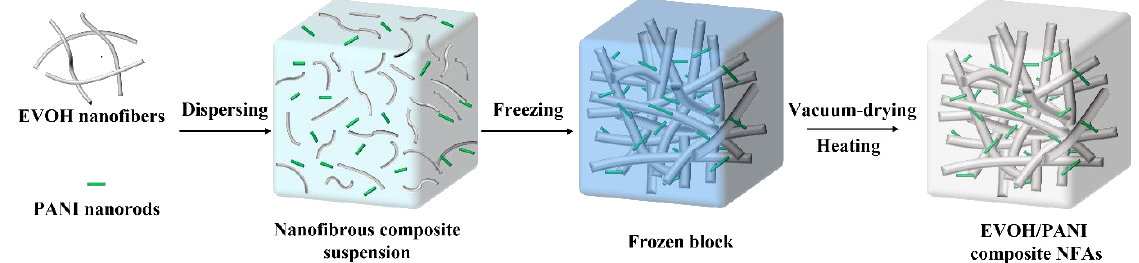
Figure 1. The schematic diagrams of the preparation of EVOH/PANI composite NFAs. Table 1. Sample name of EVOH/PANI composite NFAs.